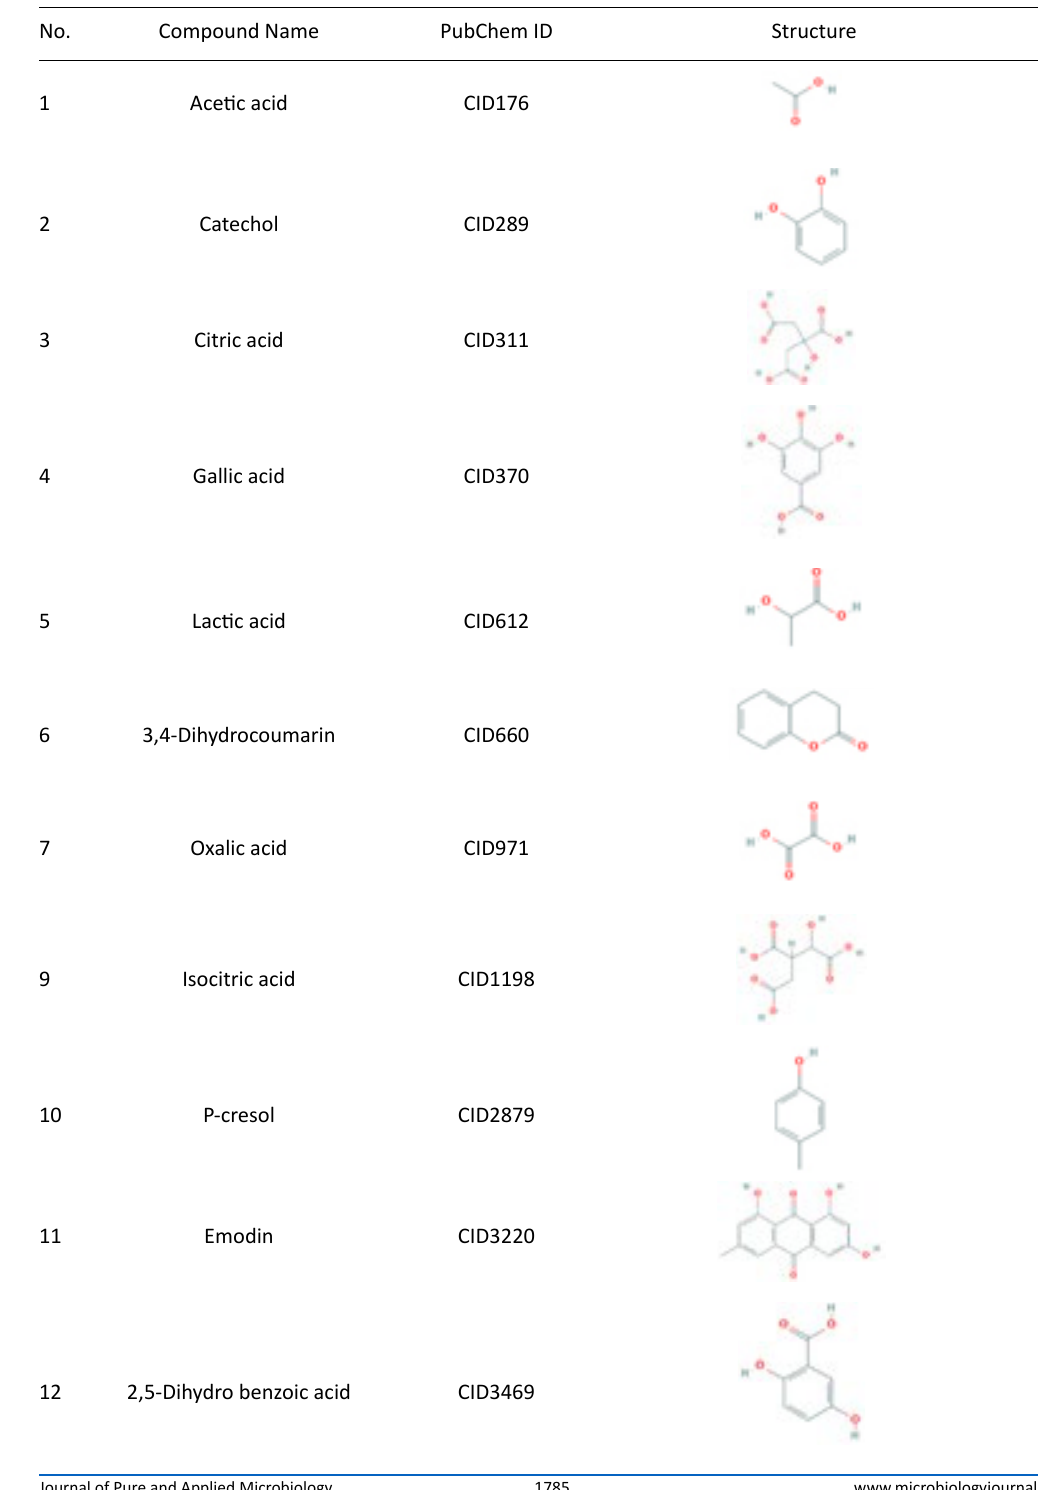
Table 1. Structure and chemical constituents